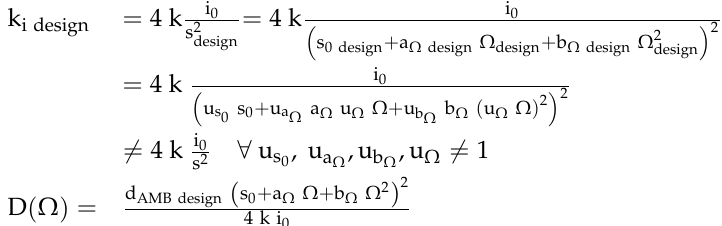
Figure 10. DVFC for the best- and worst-case combinations of all uncertainties: ( a ) Campbell diagram; ( b ) decay rate.